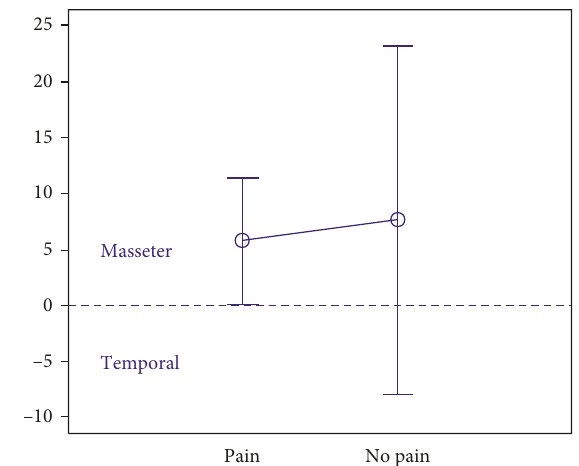
Figure 4: Activity index during maximum clenching in group of healthy individuals.